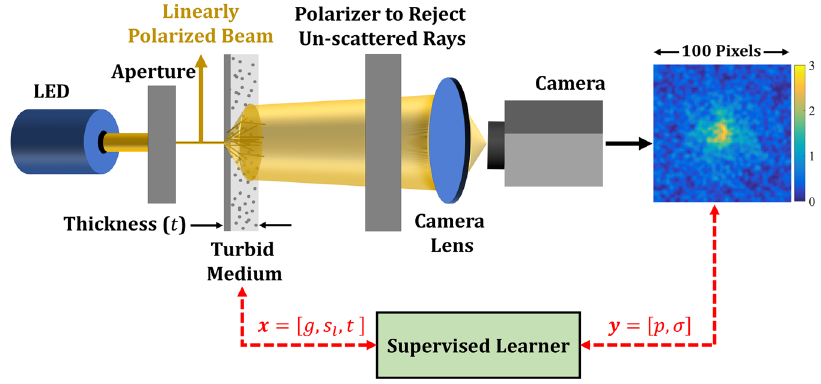
Figure 1. The schematics of the simulation setup: The image of the transmitted scattered waves on the surface of the turbid medium is used to obtain its scattering properties. The input to the turbid medium is a linearly polarized pencil beam of an LED. A free space polarizer is used to reject the un-scattered beam based on the polarization of the input LED. The color bar besides the image indicates the range of gray intensity. See the text for more details on our simulation